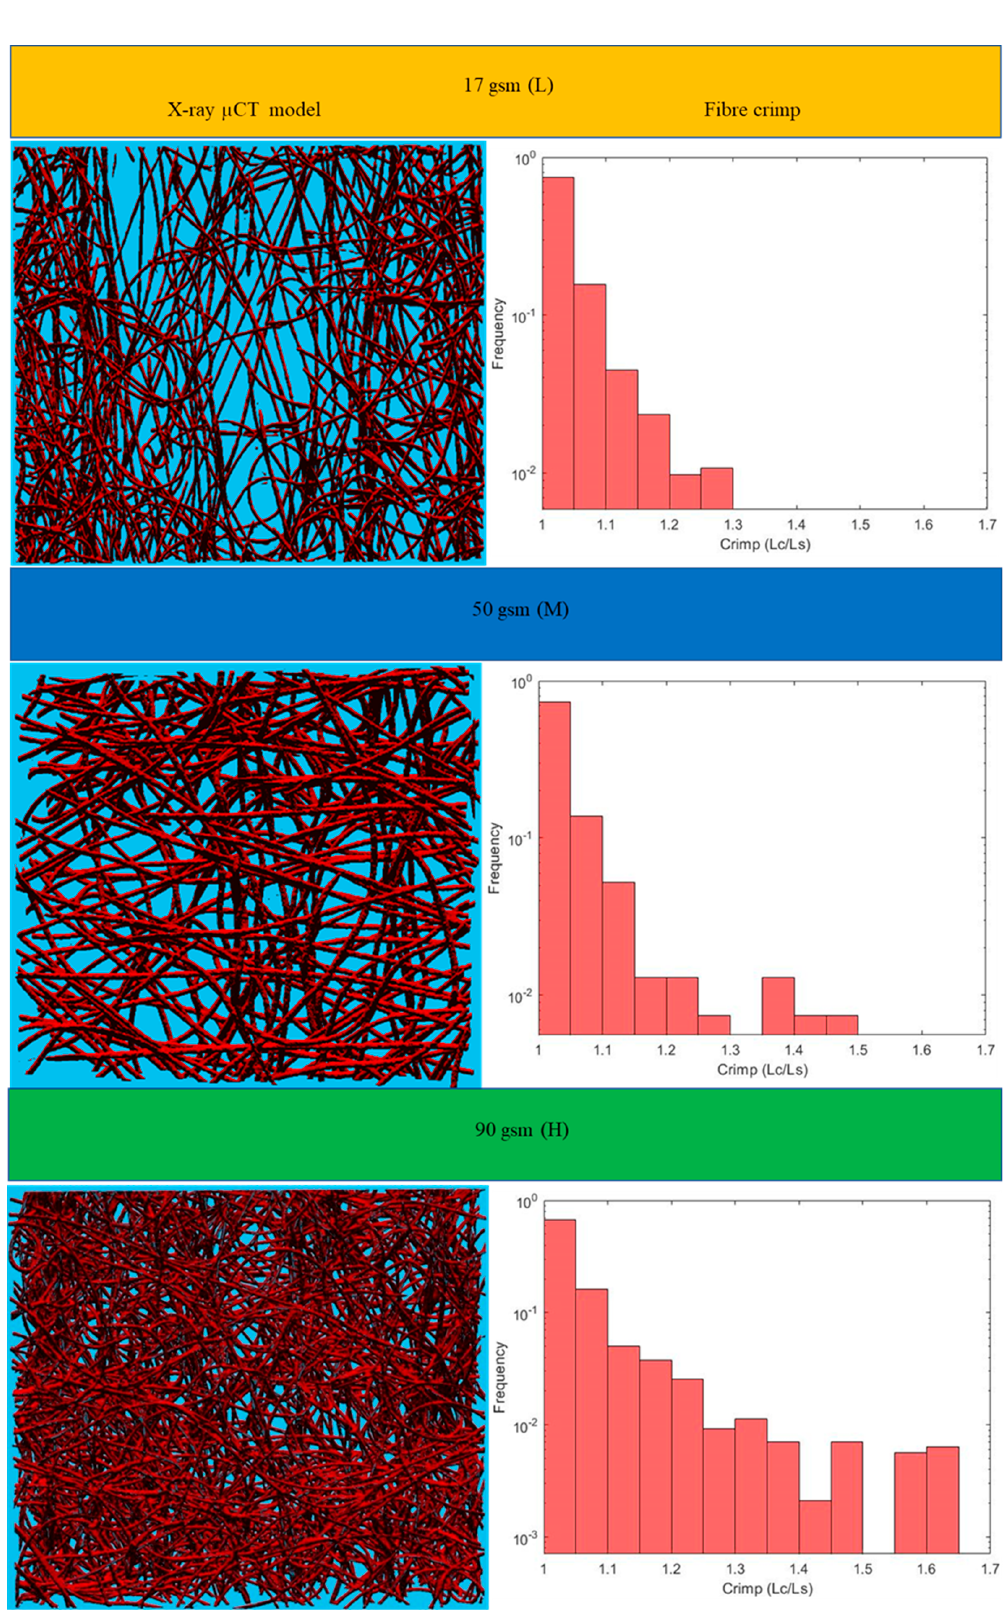
Figure 7. Distributions of 3D fibre crimp for fabrics with crimped fibres .